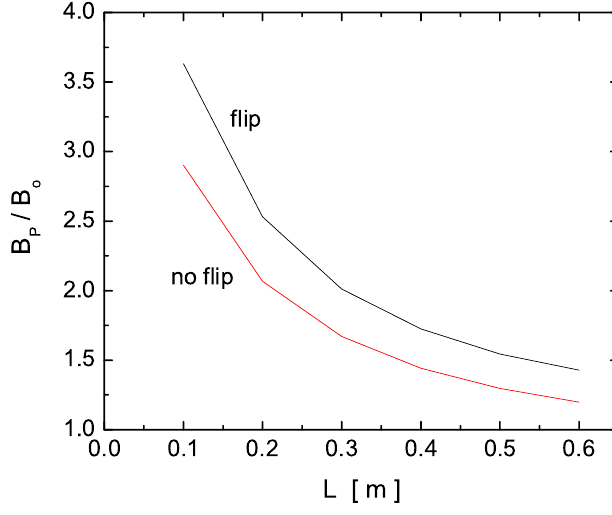
FIG. 10. (Color) Lattice parameters as a function of the solenoid FIG. 11. (Color) Peak field enhancement as a function of the inner radius for the no-flip case. The beta function at the cell length of the coil. The other parameter values were d (cid:2) 100 cm , boundary and midplane, momentum acceptance, and current a (cid:2) 40 cm , t (cid:2) 10 cm , and J (cid:2) 100 A = mm 2 fixed at 200 MeV =c are shown. The other density to keep p 2 parameter values were d (cid:2) 120 cm , L (cid:2) 40 cm , and t (cid:2) 24 cm .